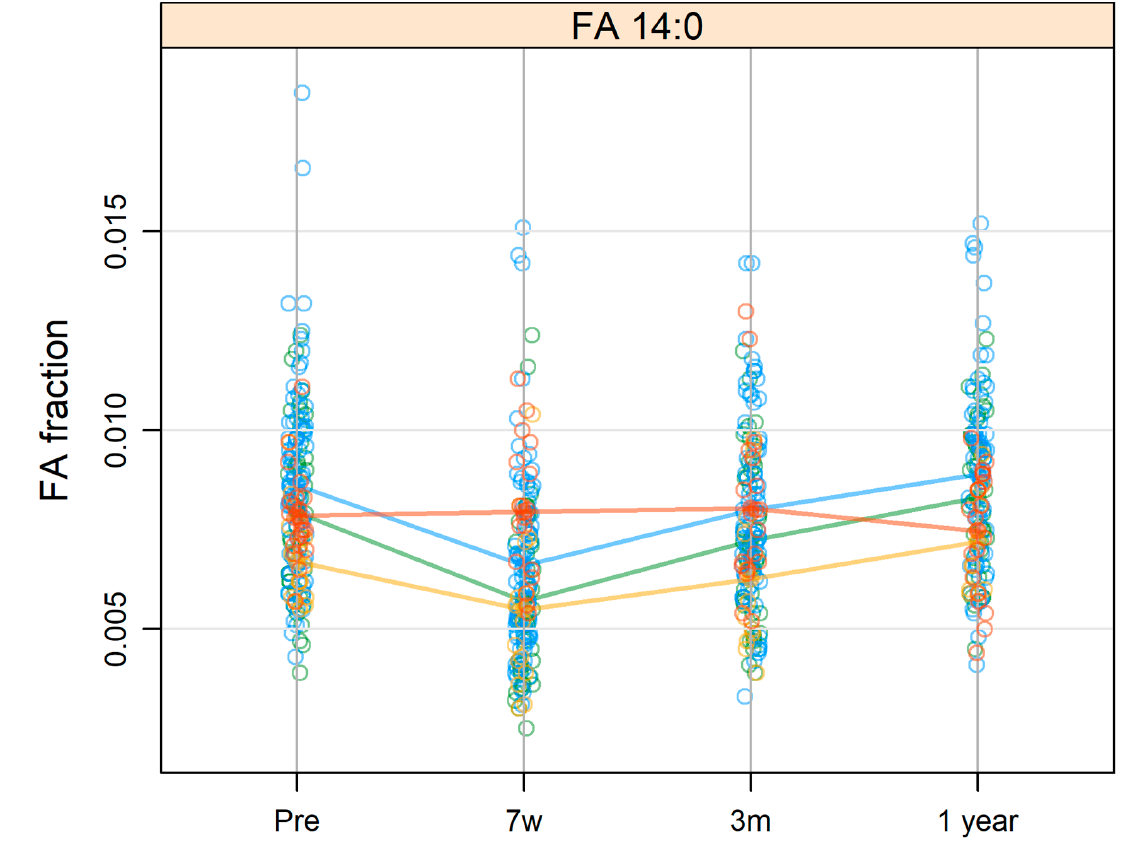
Figure 2. Levels of FA 14:0 in patients with head and neck cancer divided into different treatments (red: surgery; blue: radiotherapy; green: chemoradiotherapy; yellow: radiotherapy and cetuximab) at pre-treatment (pre), at 7 weeks after the start of treatment (7w), and at 3 months (3m) and 1 year (1 year) after the termination of treatment.